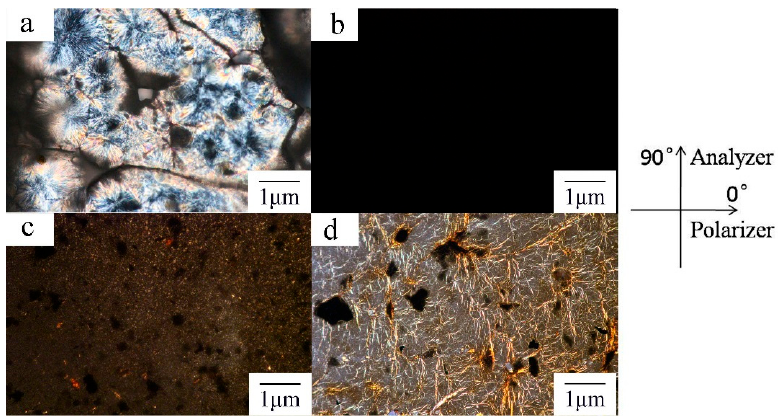
Figure 6. Representative polarizing optical microscope (POM) images of the texture of LCPU at 115 °C ( a ); LCPU5 at 145 °C ( b ); LCPU20 at 250 °C ( c ); and GO at 200 °C ( d ) (Magnification: 200×).